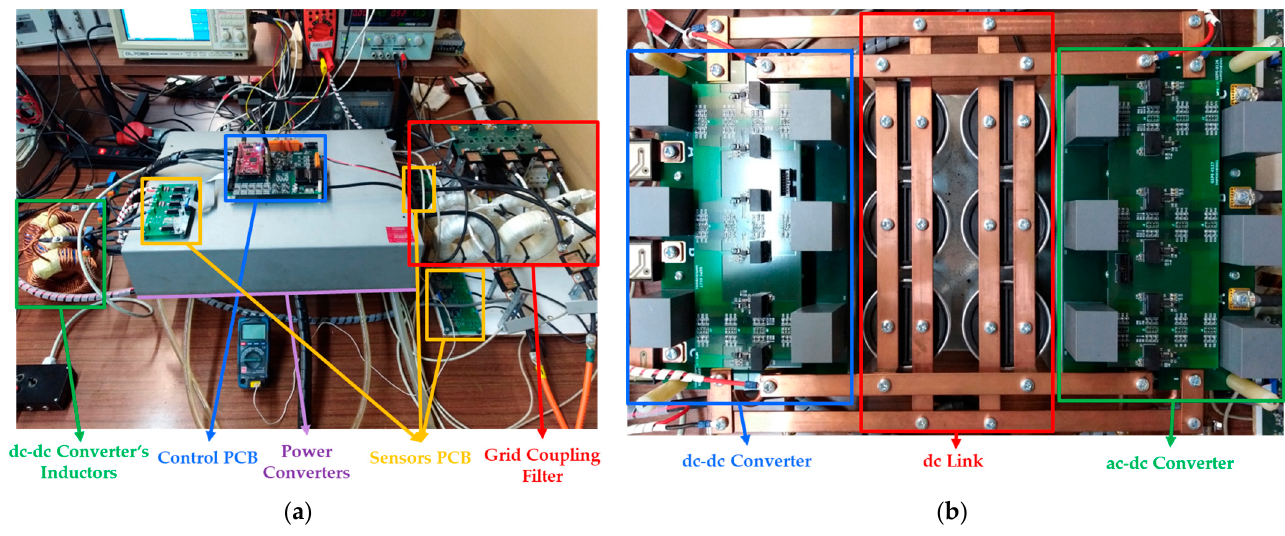
Figure 11. Traction system prototype: ( a ) external view; ( b ) internal view of the power converters.